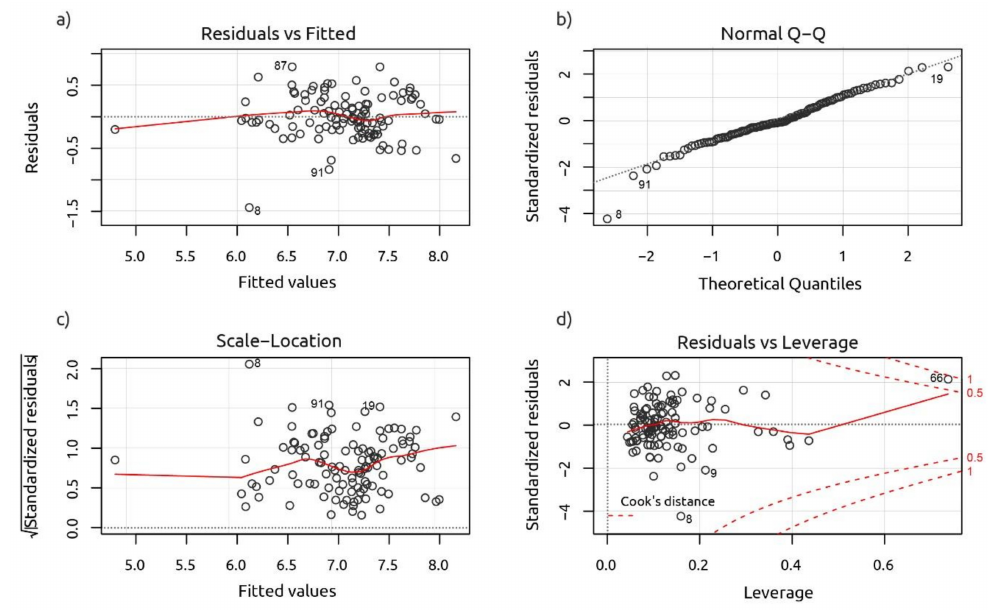
Figure 5. ( a ) Regression model diagnostic plots: linearity of residuals; ( b ) deviation of residues from normality; ( c ) homoskedasticity of residuals; ( d ) indentification of potential influential